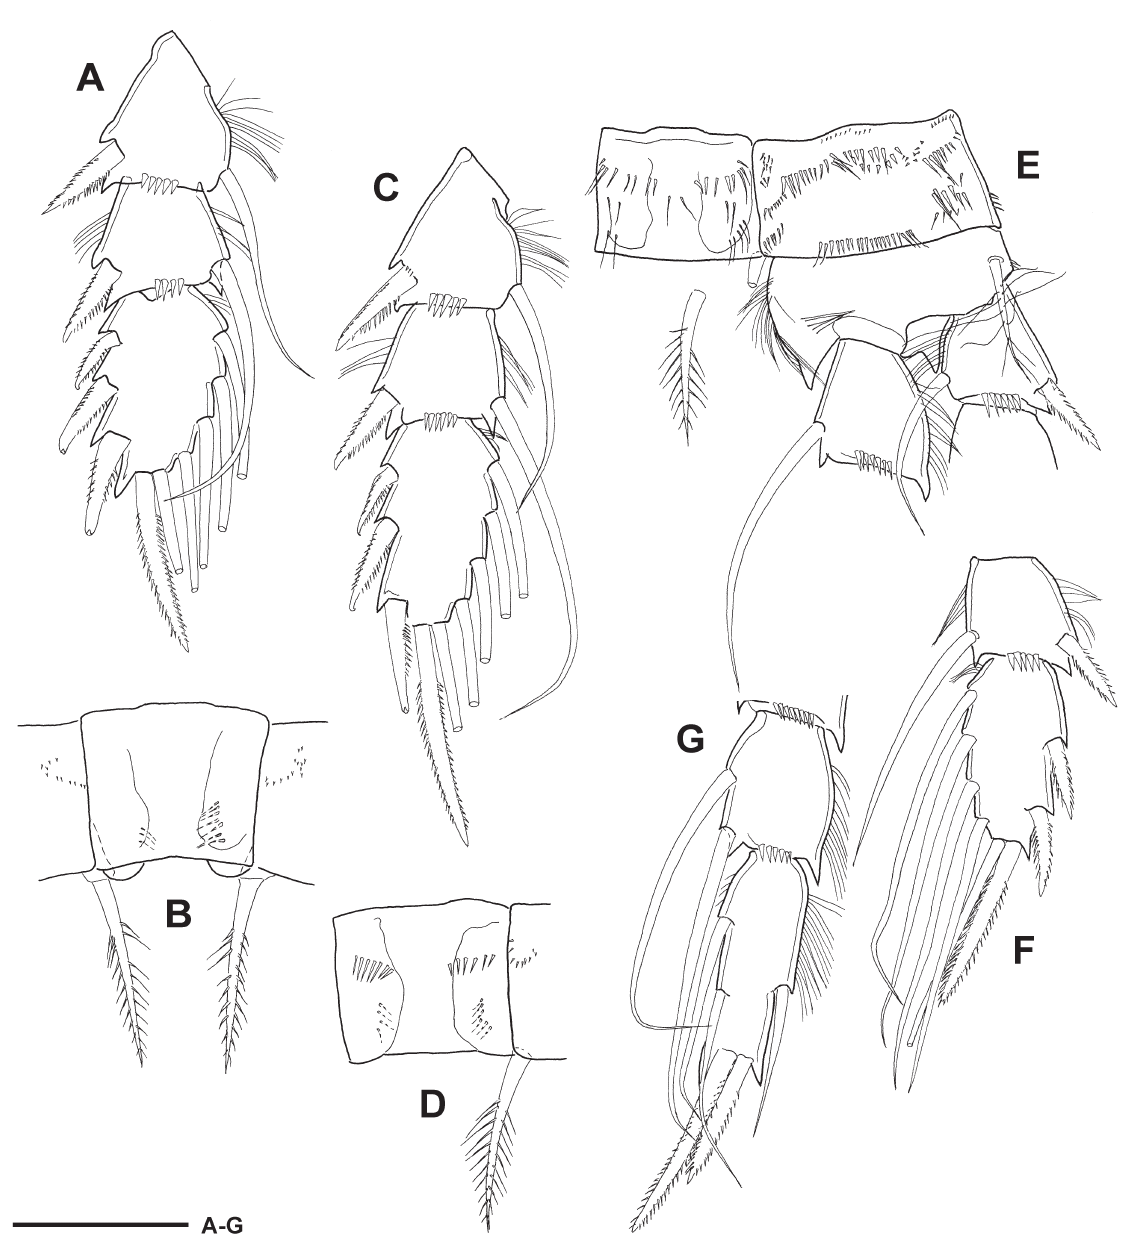
Fig. 10. Eucyclops agiloides (G.O. Sars,1909), ♀ (Lake Tanganyika, Kirando; NHM). A . Leg 2 exo- podite, caudal view. B . Leg 2 intercoxal sclerite, caudal view – ornamentation on the frontal surface is indicated by dotted line. C . Leg 3 exopodite, caudal view. D . Leg 3 intercoxal sclerite, caudal view − ornamentation on the frontal surface is indicated by dotted line. E . Leg 4, protopodite and first exopodal and endopodal segments, caudal view (coxal seta is figured separately). F . Leg 4, second and third exopodal segments, caudal view. G . Leg 4, second and third endopodal segments, caudal view. All drawings show ♀-1. Scale bars: A−G = 50